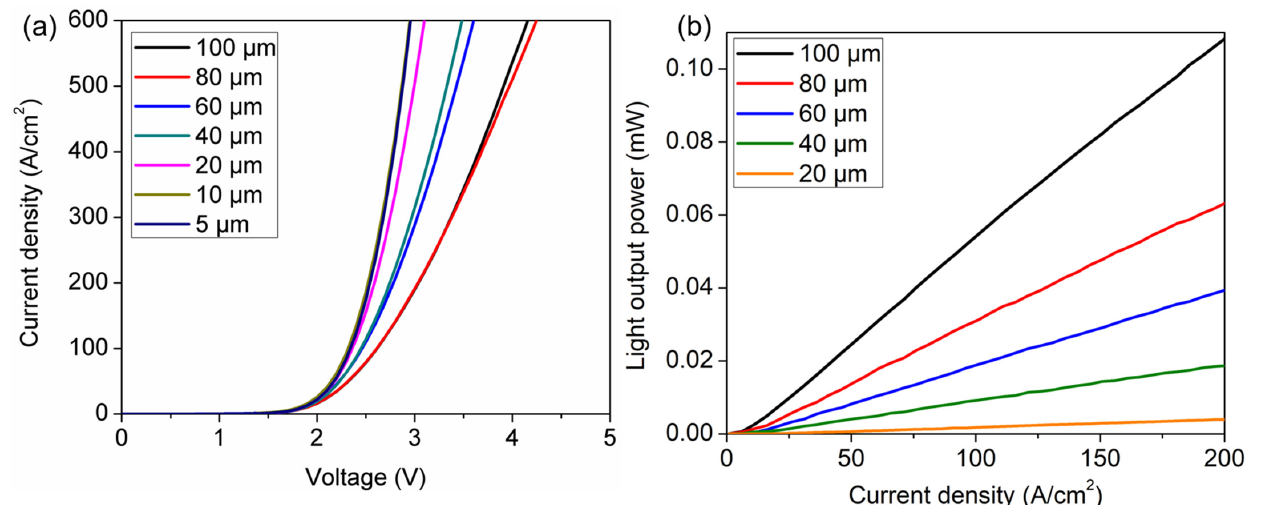
Figure 3. ( a ) Current density–voltage characteristics and ( b ) LOP–current density characteristics of the packaged red InGaN devices.